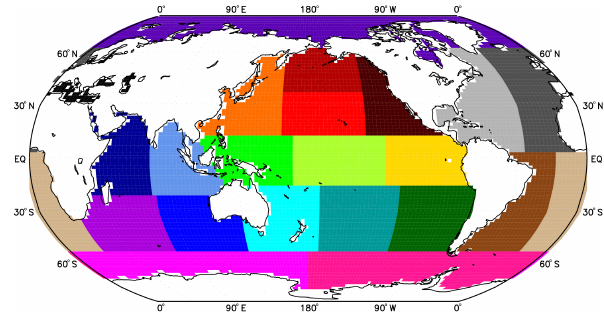
Figure 2. The 22 regions that were perturbed (see Sect. 3.1) in this study. Regions are approximately equal in area, and no region spans multiple ocean